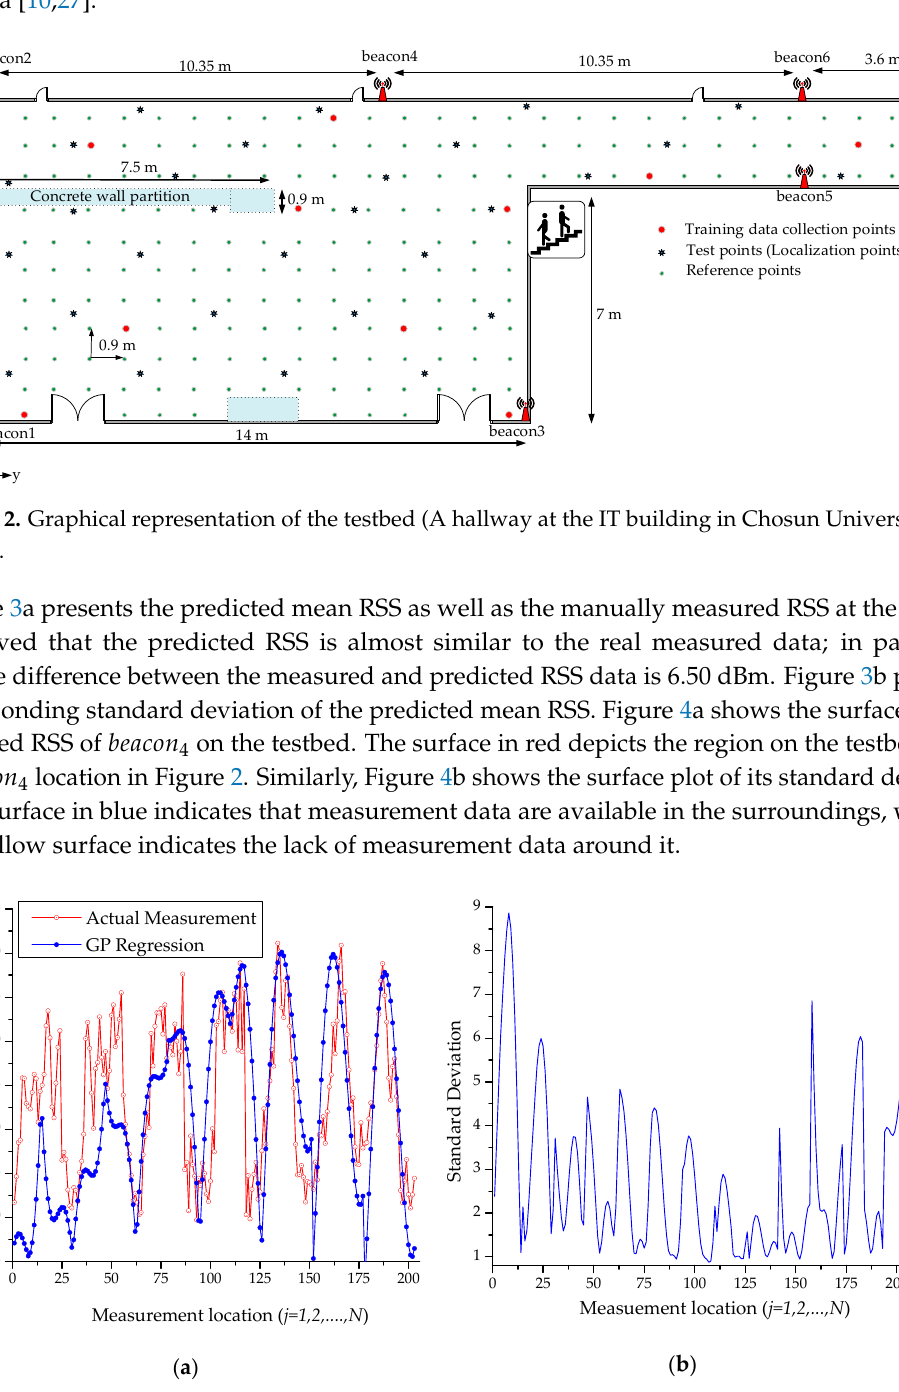
( b ) Figure 4. Surface plot of 𝑏𝑒𝑎𝑐𝑜𝑛 (cid:2872) signal ( a ) predicted RSS, ( b ) corresponding standard deviation.